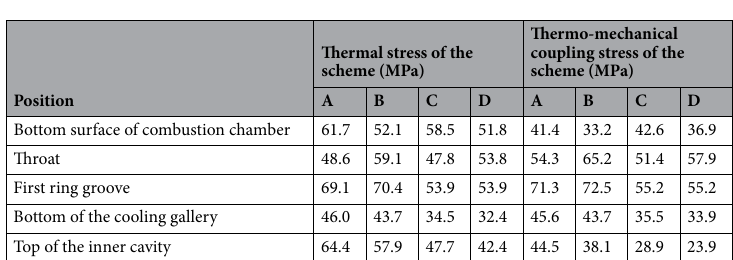
Thermo-mechanical coupling stress of the scheme (MPa)